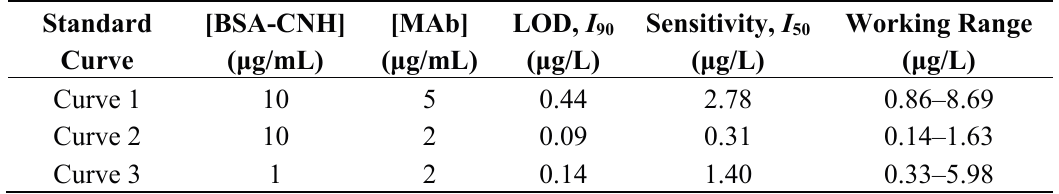
Table 1. Analytical parameters obtained from the curves of the different hapten-conjugate and monoclonal antibody (MAb) concentration